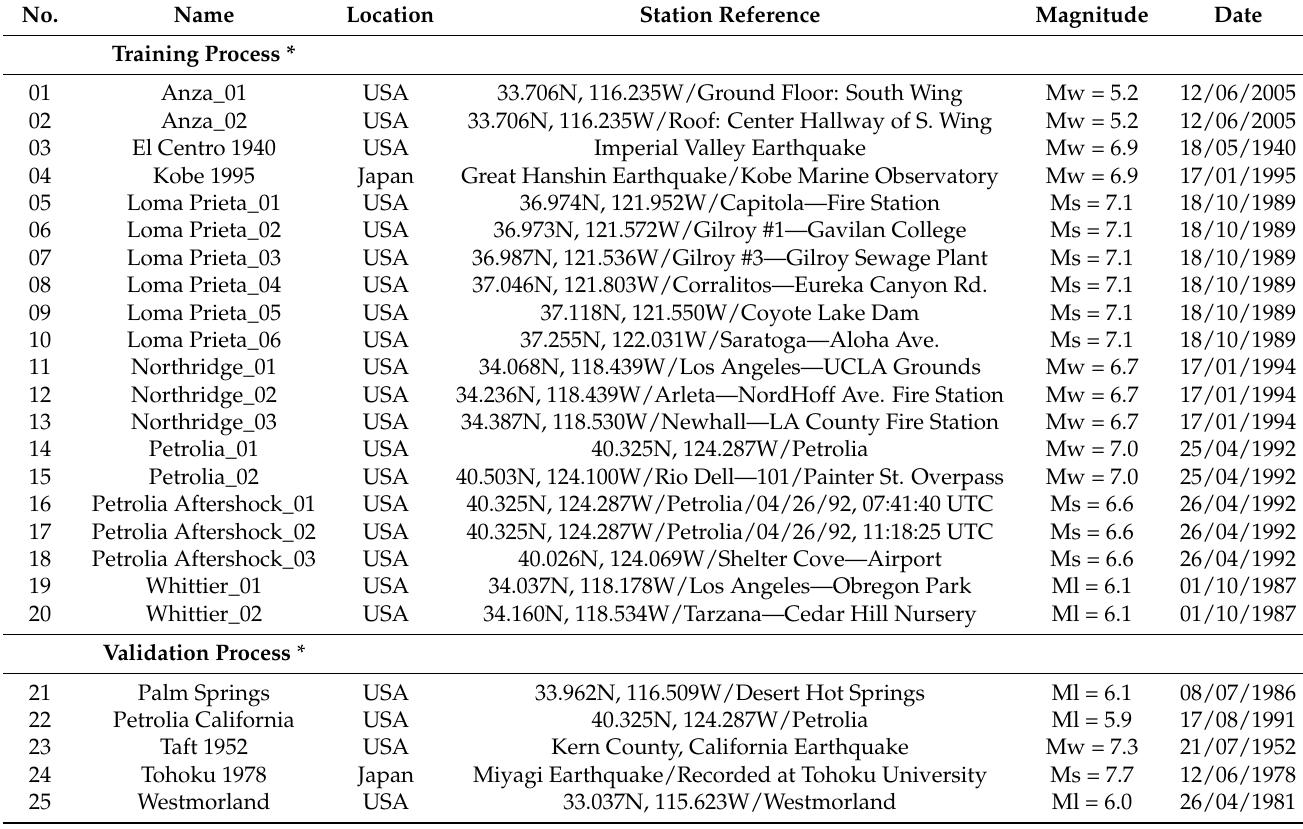
Figure 16. Bilinear hysteresis model for each story. Table 5. Earthquake ground